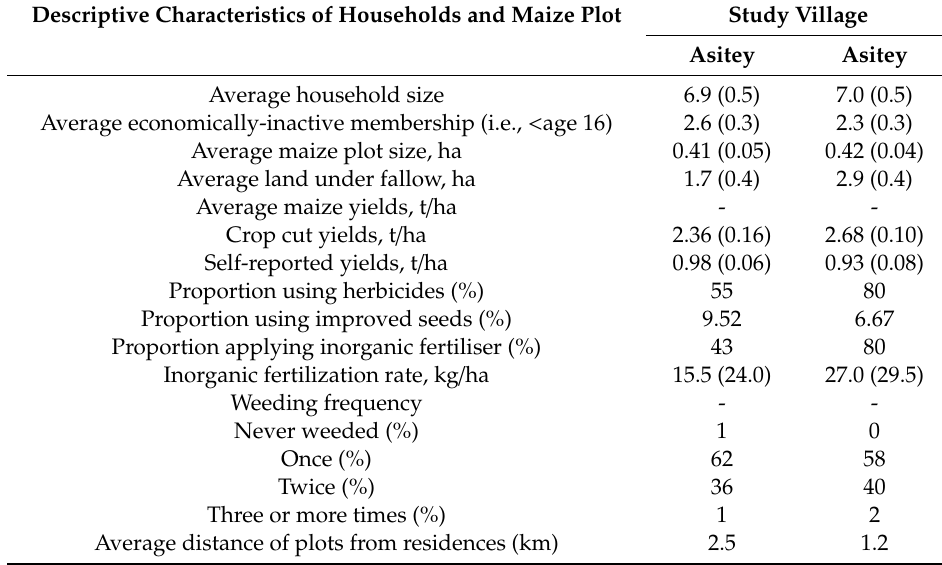
Table 3. Descriptive characteristics of households and plots from both study villages. Descriptive Characteristics of Households and Maize